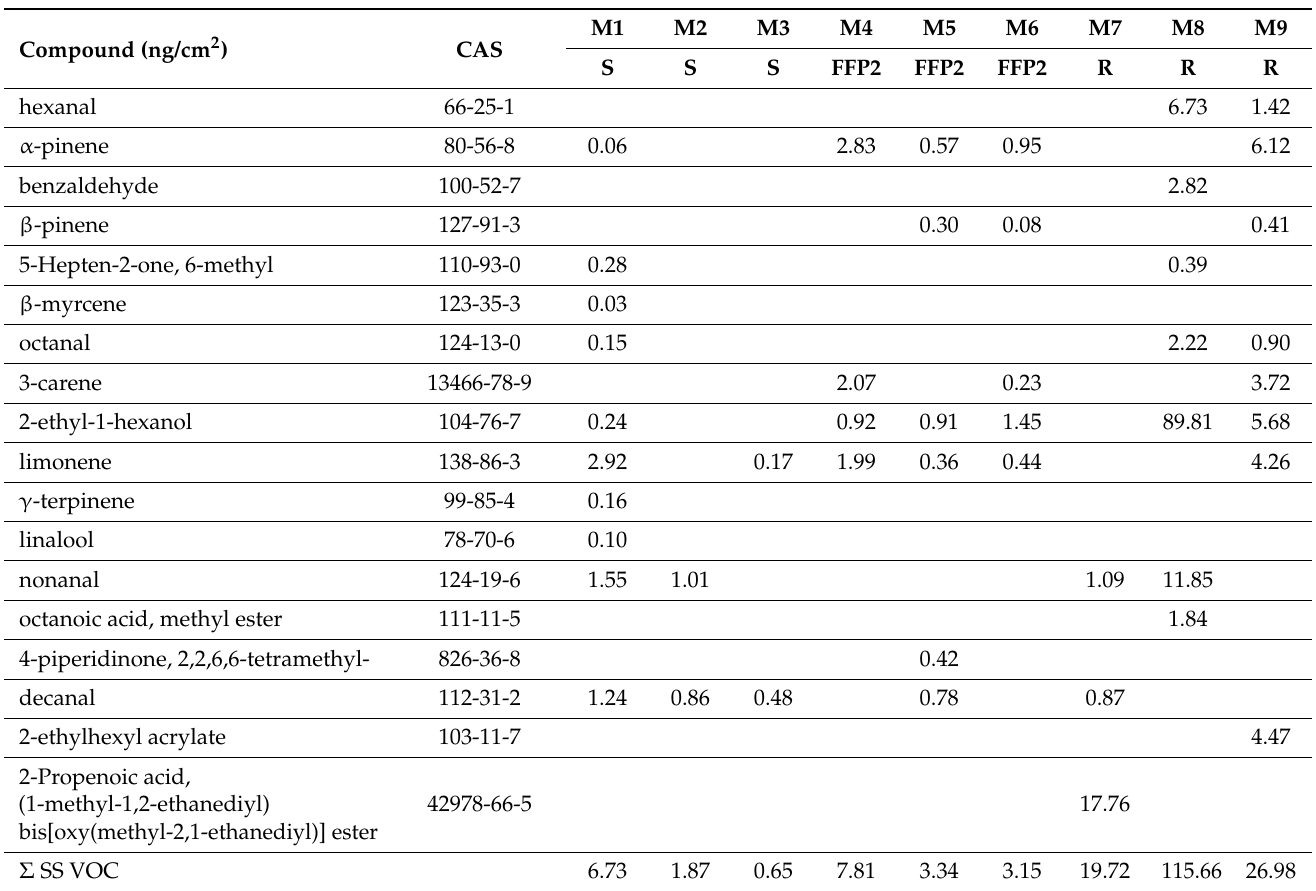
Table 4. Skin sensitization VOCs (ng/cm 2 ) concentration for the nine facemasks analyzed of